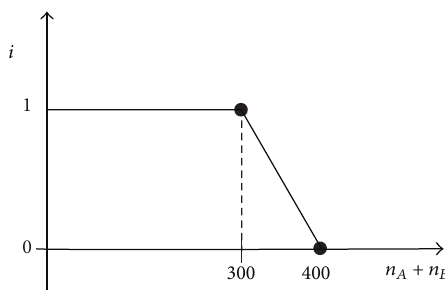
Figure 2: Function of the harmony coefficient 𝑖